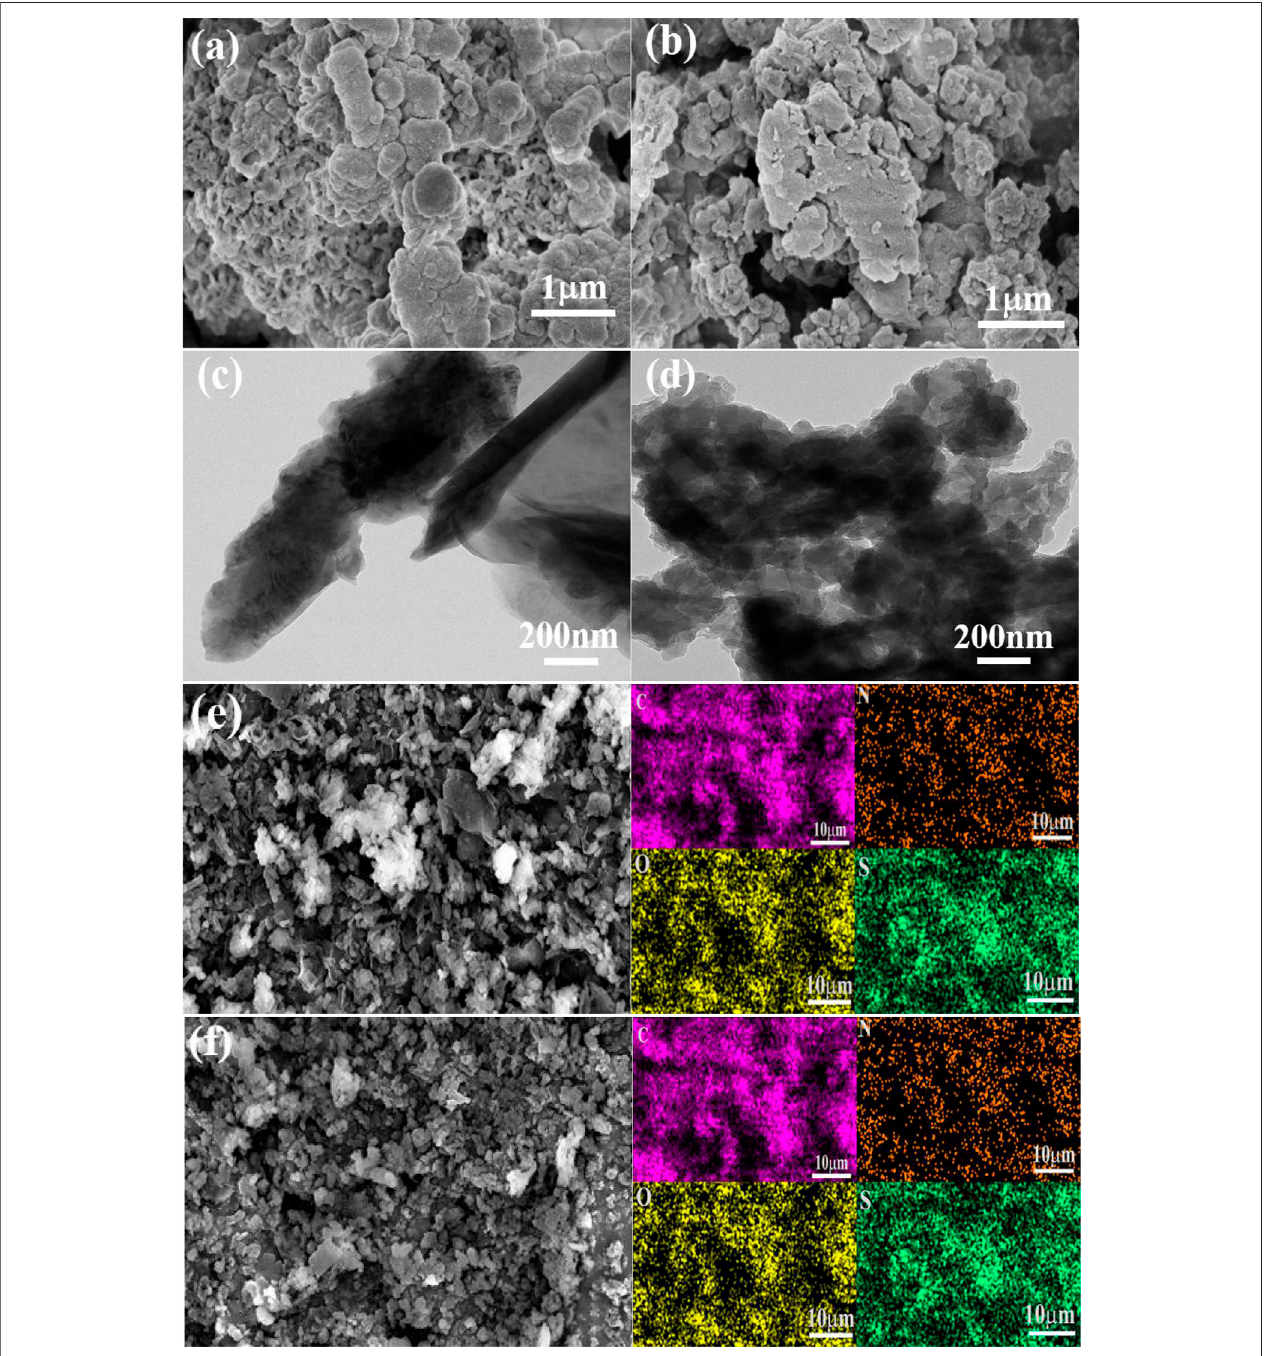
FIGURE 1 | SEM image for CMP-1 (A) and CMP-2 (B) . TEM image of CMP-1 (C) and CMP-2 (D) . EDS element mapping images of CMP-1 (E) and CMP-2 (F) .